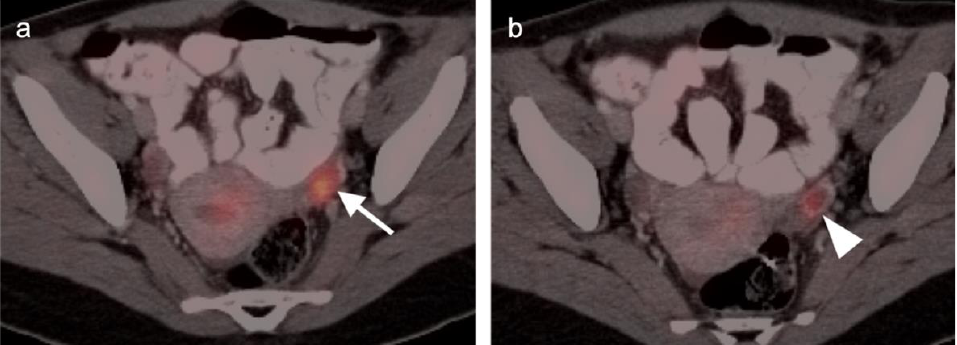
Figure 5. Normal functional ovarian metabolic activity on axial FDG PET-CT images of the pelvis. ( a ) Maturing ovarium follicle with a homogeneous nodular focus of increased metabolic activity (white arrow); ( b ) Corpus luteum cyst with a ring enhancing, hypermetabolic nodule (white arrowhead).